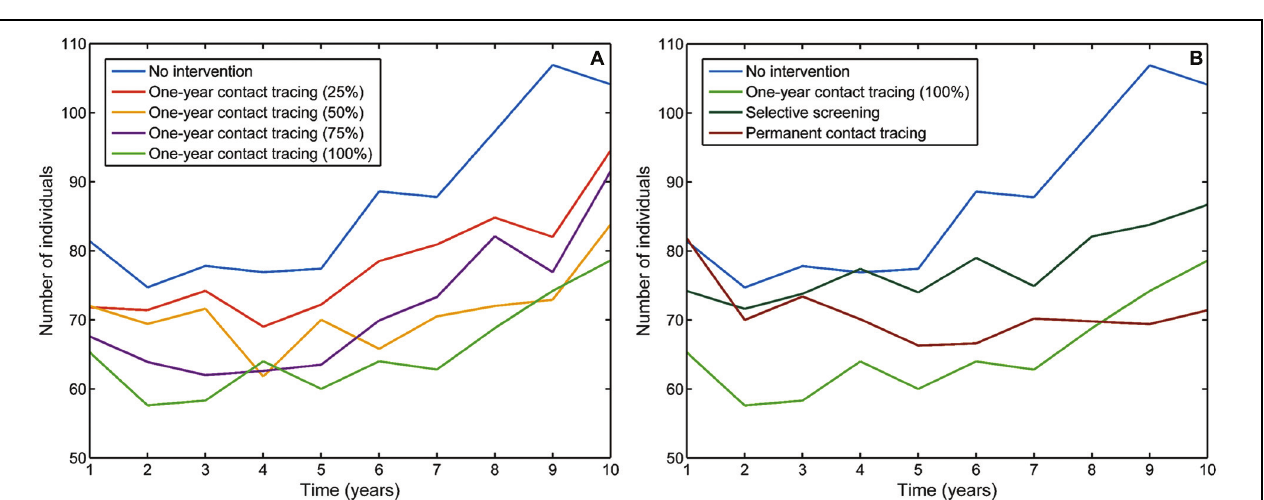
FIGURE 7 | Infection time distribution observed in virtual experiments after 1, 4, 6, and 10 years, depending on the initial infection time distribution among a 4,500 infected-subpopulation (blue: initial uniform distribution; green: initial decreasing exponential distribution; red: initial increasing exponential distribution; shown in Figure 5).